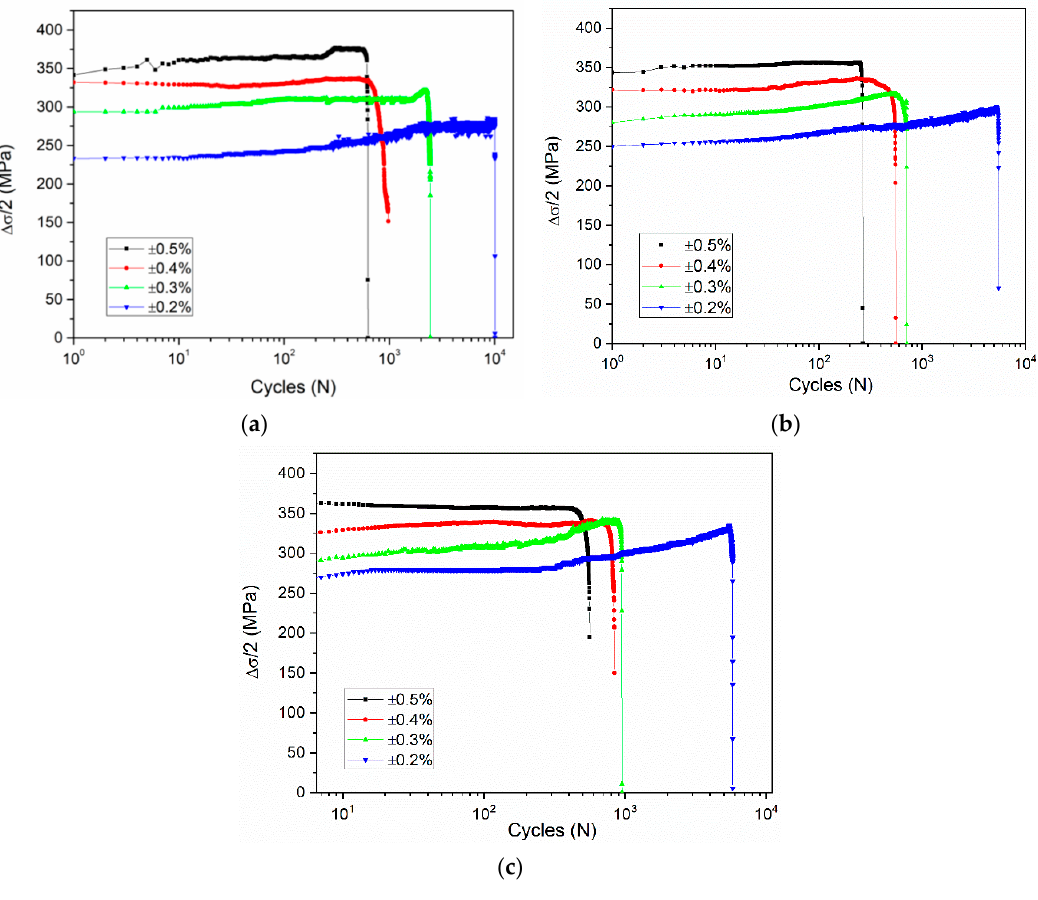
Figure 2. Cyclic stress response of the steel at 600 °C ( a ) air environment, ( b ) mixed chloride salt environment, and ( c ) mixed sulfate salt environment. Table 3. Tensile mechanical properties of 12Cr1MoV steel.